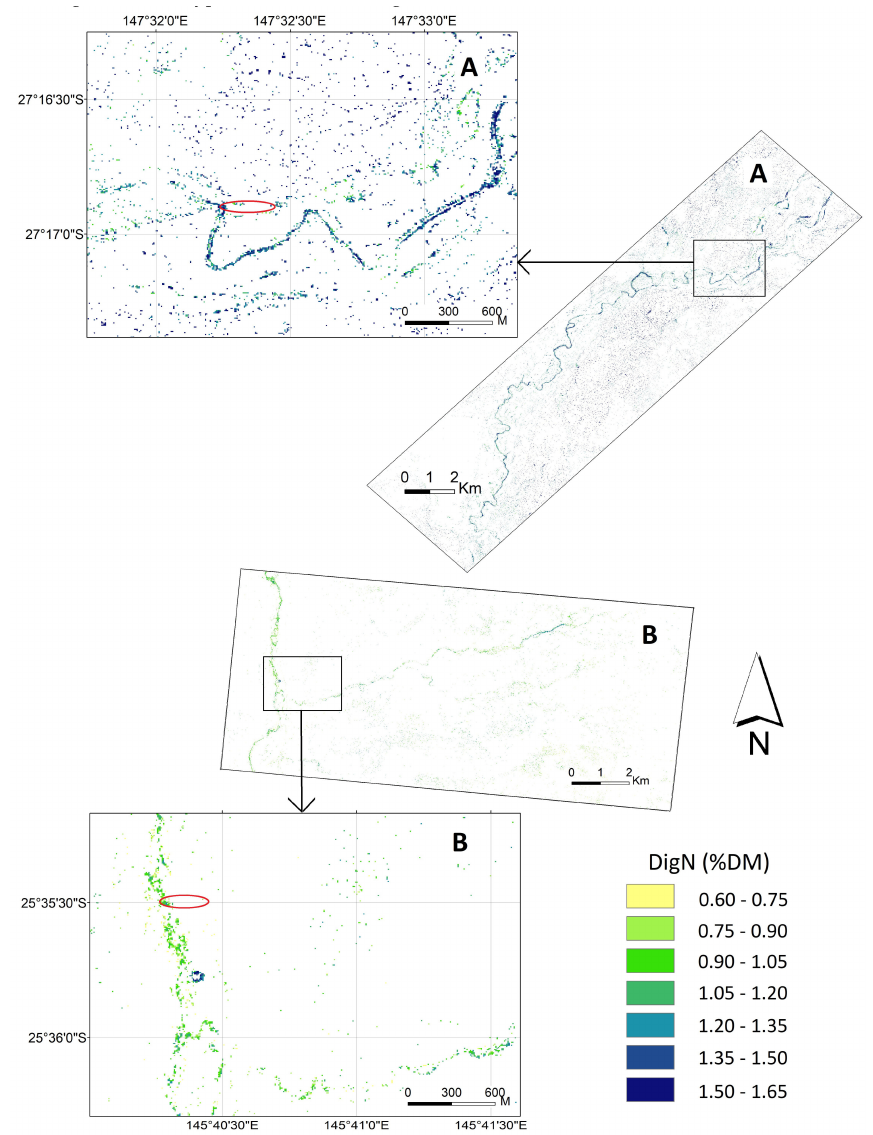
Figure 7. Maps of foliar digestible nitrogen (DigN) at Landscape A and B in colour. Black boxes in full maps indicate locations of zoomed-in areas. Red circles in zoomed-in areas indicate locations of sample sites. Features in non-tree areas (soil, water and grass) are